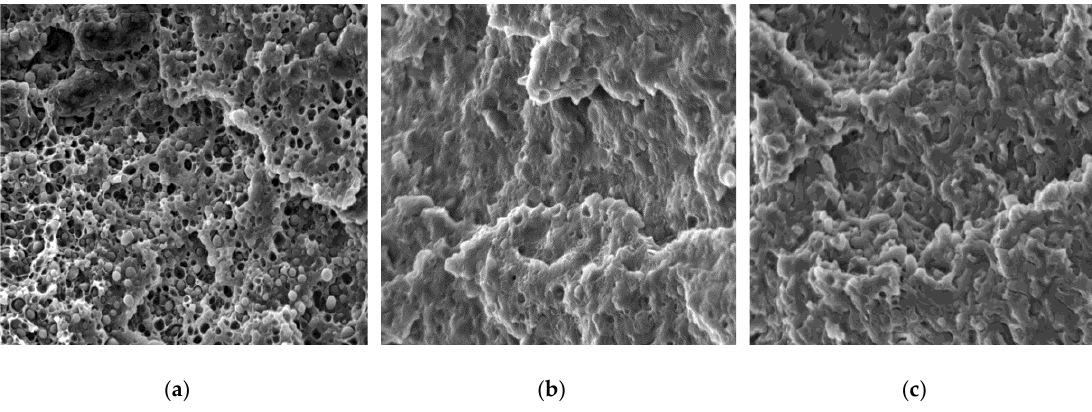
Figure 5. Micrographs of: ( a ) PLA/PHB, ( b ) PLA/PHB0.1SYN, and ( c ) PLA/PHB/1HLB12.